Question: Is the quantity shown trending increasing or decreasing?
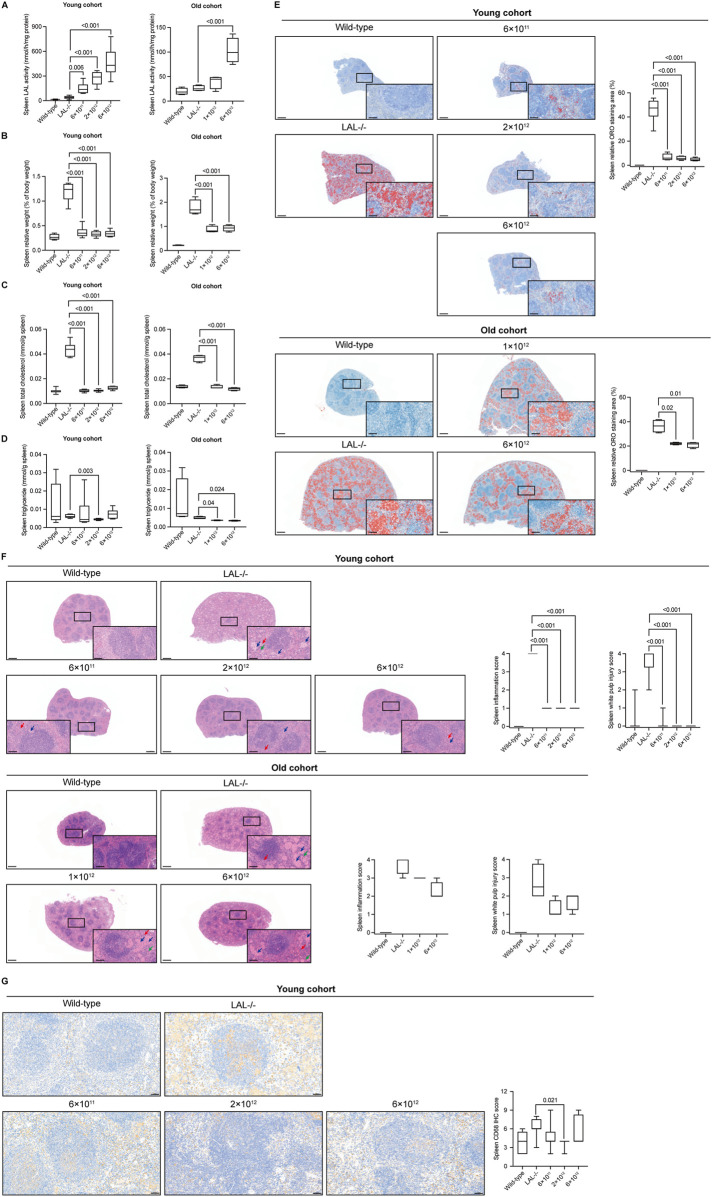
Answer: increasing